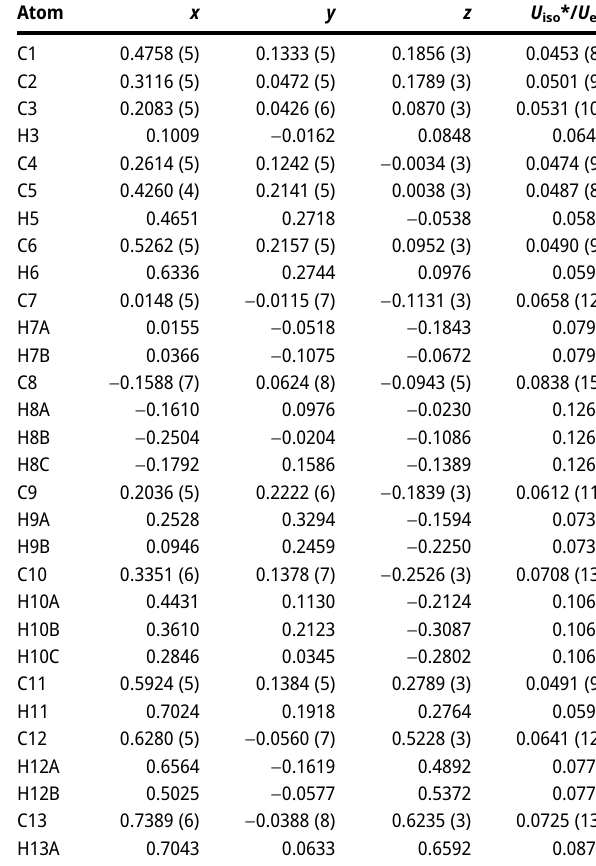
Table  : Fractional atomic coordinates and isotropic or equivalent isotropic displacement parameters (Å 